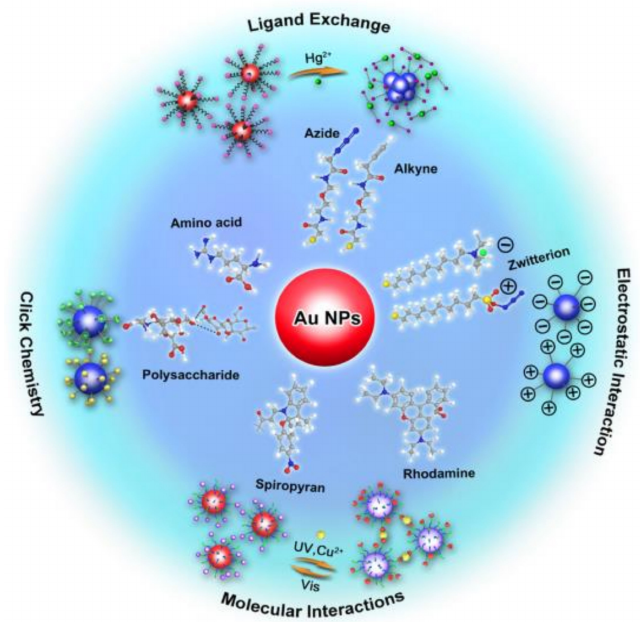
Figure 28. Surface chemistry strategy for the working and application in the biochemical study of Au NPs with small molecules. Reproduce with permission from reference [205], Copyright 2017, ACS.